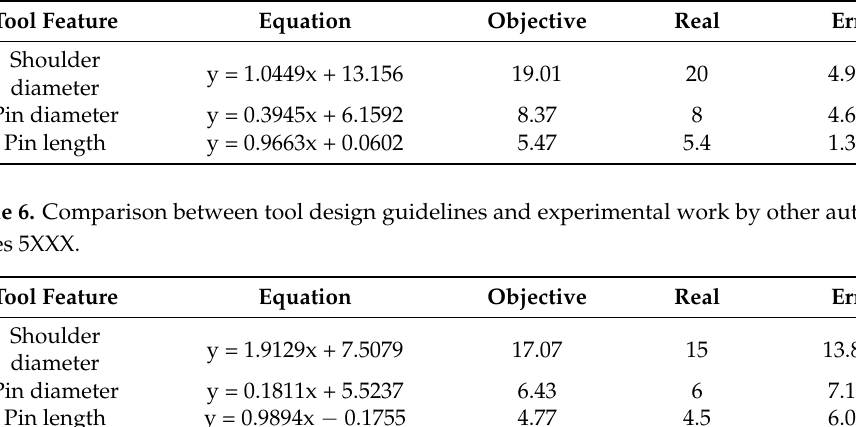
Figure 9. Tool design: ( a ) pin; ( b ) shoulder.